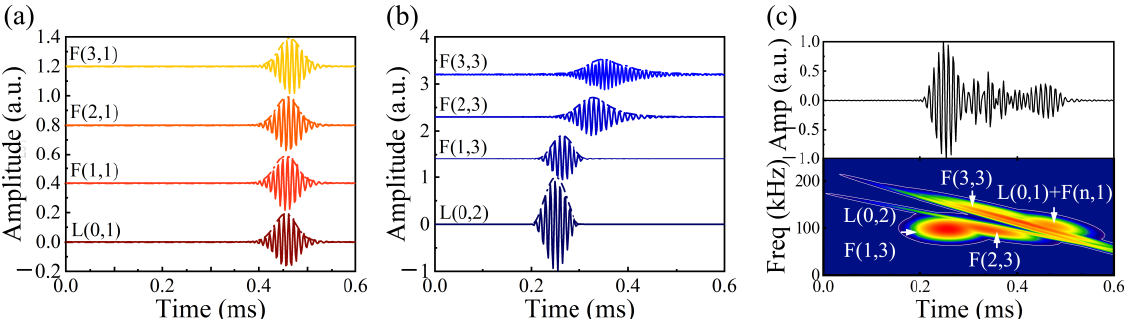
Figure 5. Signals of ( a ) L(0,1) + F( n ,1), ( b ) L(0,2) + F( n ,3) UGWs in the time domain, and signals of ( c ) synthesized UGW signal in time and frequency domains.